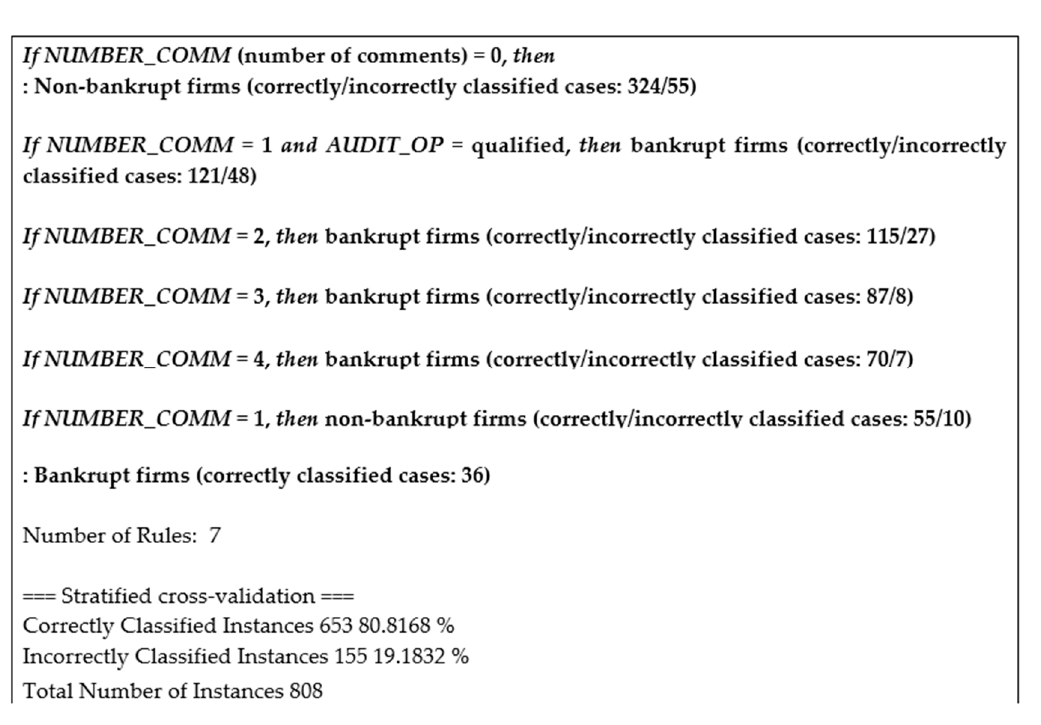
Figure 3. Model 3: The audit opinion, type of paragraphs, and number of comments in the PART model.